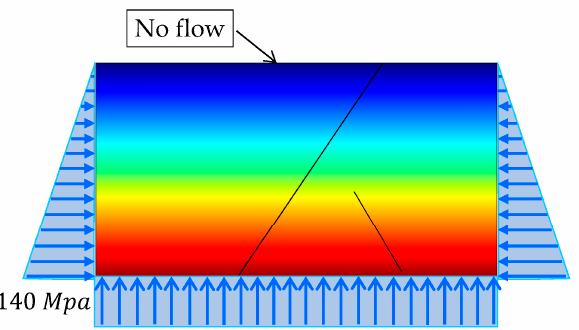
Figure 6. Hydrostatic constraints and pressure field in the interseismic